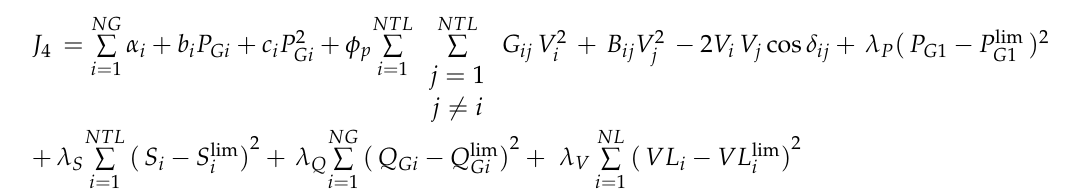
Table 3. The optimization results for Type 2.